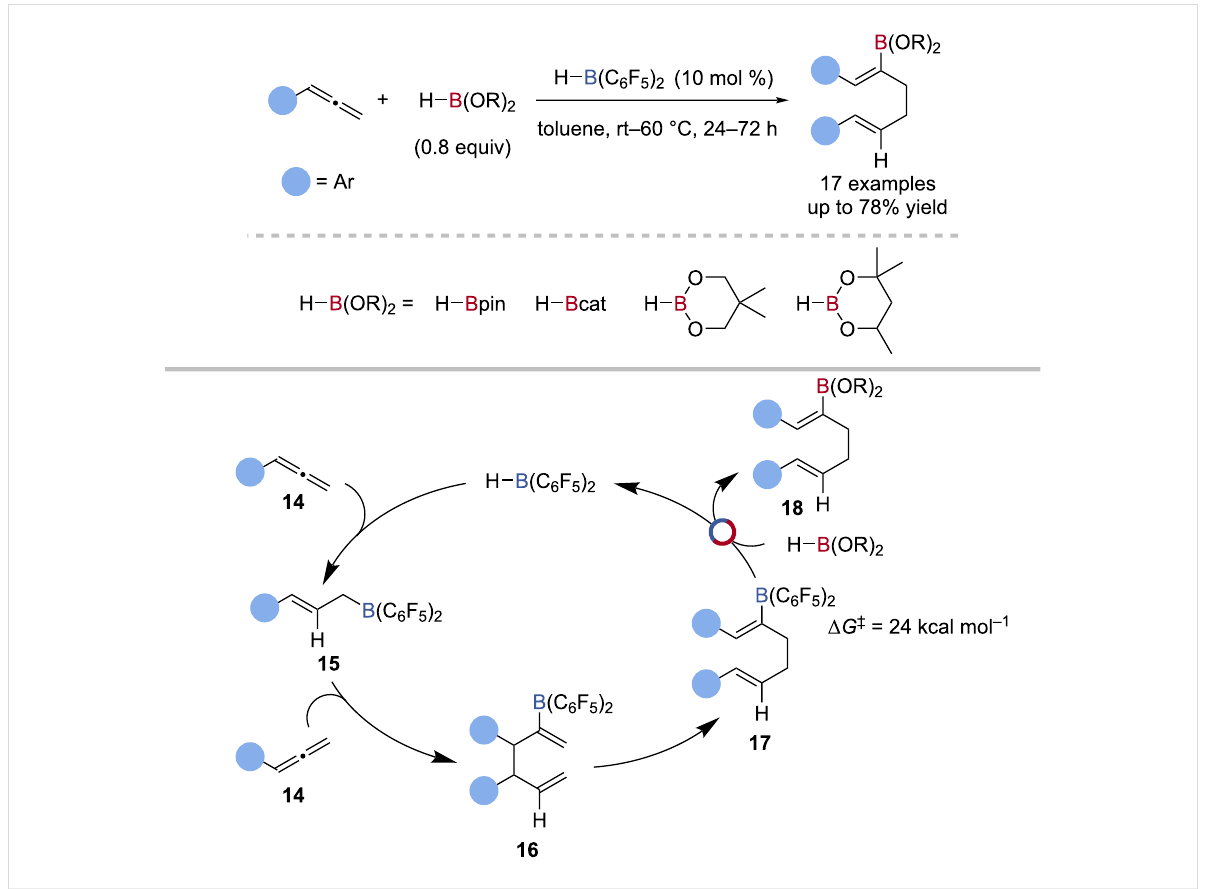
Scheme 5: Bis(pentafluorophenyl)borane-catalysed dimerisation of allenes and the proposed